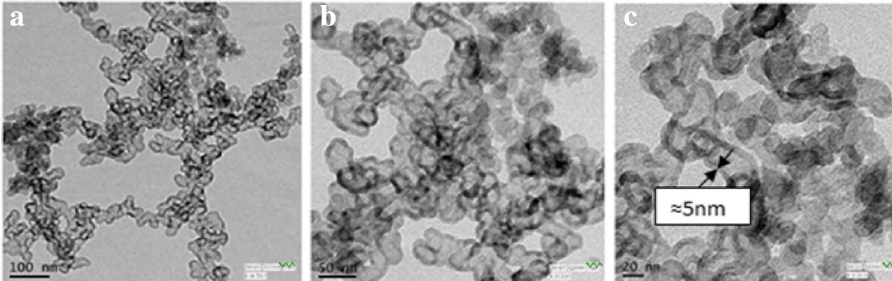
Fig. 1 TEM image of a 100, b 50, c 20 mm scale (indicated inside figure) of NDCP catalysts,